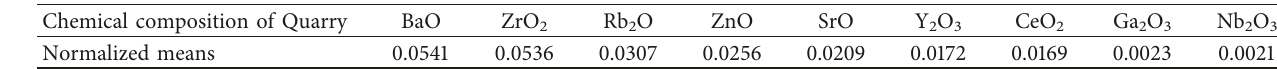
Table 2: % of chemical composition of recycled Quarry.